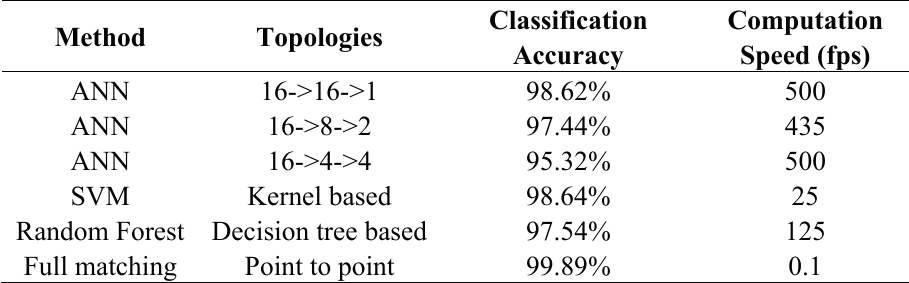
Table 2. Performance comparison with 320 × 240 image